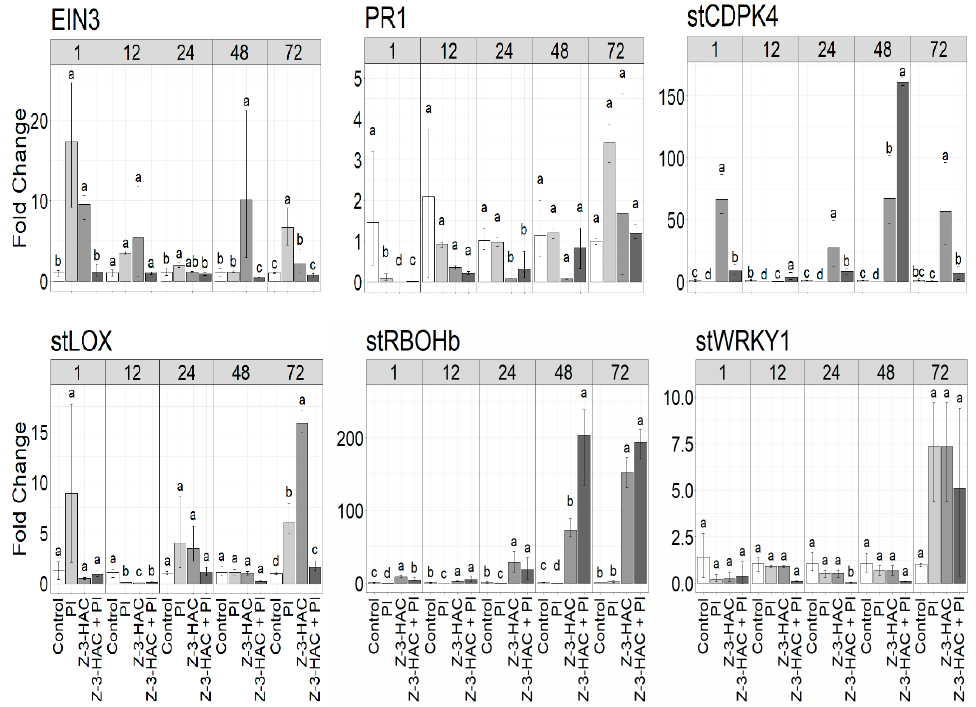
Figure 6. Expression profiles (fold change) of stPR-1, stLOX, stWRKY1, EIN3, stRBOHb and stCDPK4 genes in potato plants 1, 12, 24, 48 and 72 h after exposure with the GLV Z-3-HAC. Pre-exposed plants were challenged with sporangial suspension of P. infestans (EU-13-A2) after exposure. PI: not pre-exposed, infected; Z-3-HAC: pre-exposed, not infected; Z-3-HAC + PI: pre-exposed, infected; control: not pre-exposed, not infected. Bars sharing the same letters represent values that are not significantly different according to Dunn’s test ( p > 0.05).